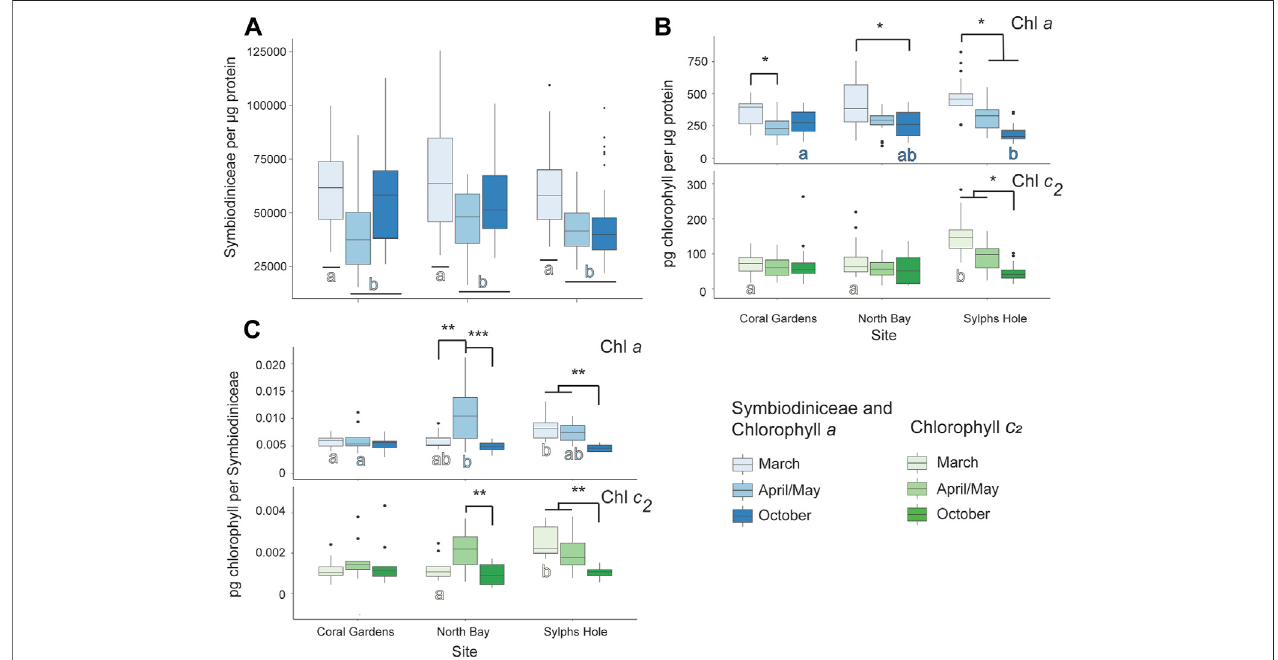
FIGURE7| Marineheatwaveeffectsonunbleached Xeniacfcrassa acrossthreereefs intheLordHoweIslandlagoon. (A) Symbiodiniaceaedensityperµgprotein in unbleached Xenia cf crassa colonies during March, April/May, and October. (B) Chlorophyll a (above) and c 2 (below) densities per µg protein in unbleached Xenia cf crassa colonies during March, April/May, and October. (C) Chlorophyll a (above) and c 2 (below) densities per Symbiodiniaceae cell in visually healthy Xenia cf crassa coloniesduringMarch, April/May, andOctober.Signi fi canceisdesignatedeitherbydifferentlettergrouporbyabar. p -valuesarerepresentedasfollows — *for p < 0.05, ** for p < 0.005, and *** for p < 0.0005. Where more than one plot is grouped together, the highest p -value is reported. Bars above the boxplots represent monitoring interval differences within site, and letters below the boxplots represent site differences within monitoring intervals.